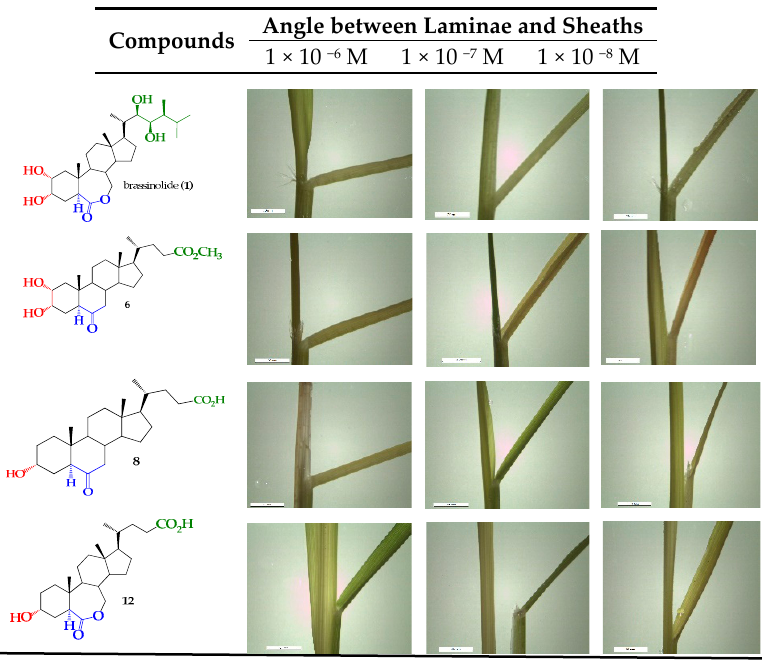
Figure 4. Rice-lamina assay using the second leaf lamina joints of excised leaf segments treated with brassinolide ( 1 ) and more active BR analogs at 1 × 10 − 6 , 1 × 10 − 7 and 1 × 10 − 8 M. Scale bars = 2 cm.